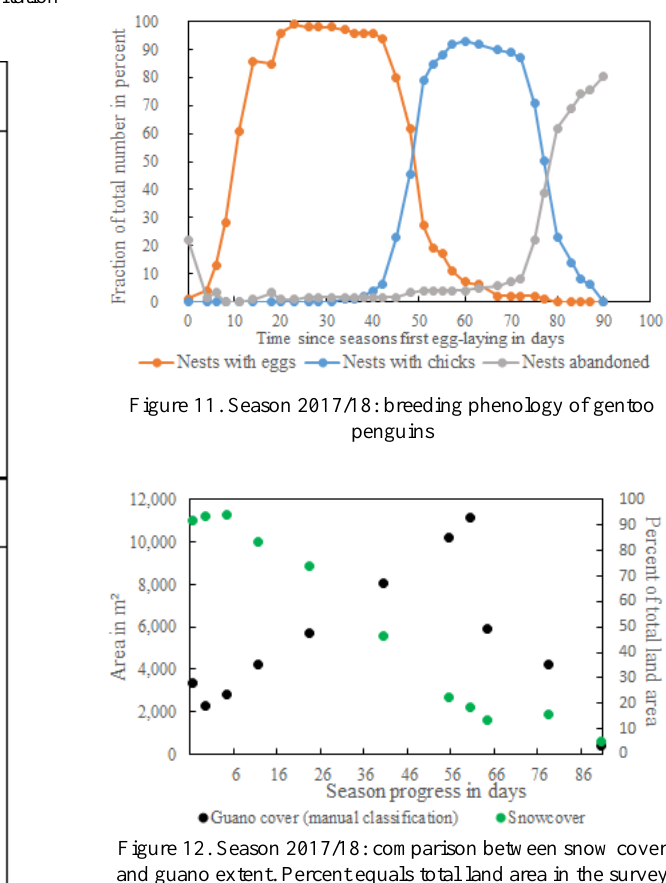
Figure 10. Season 2017/18: different classification results